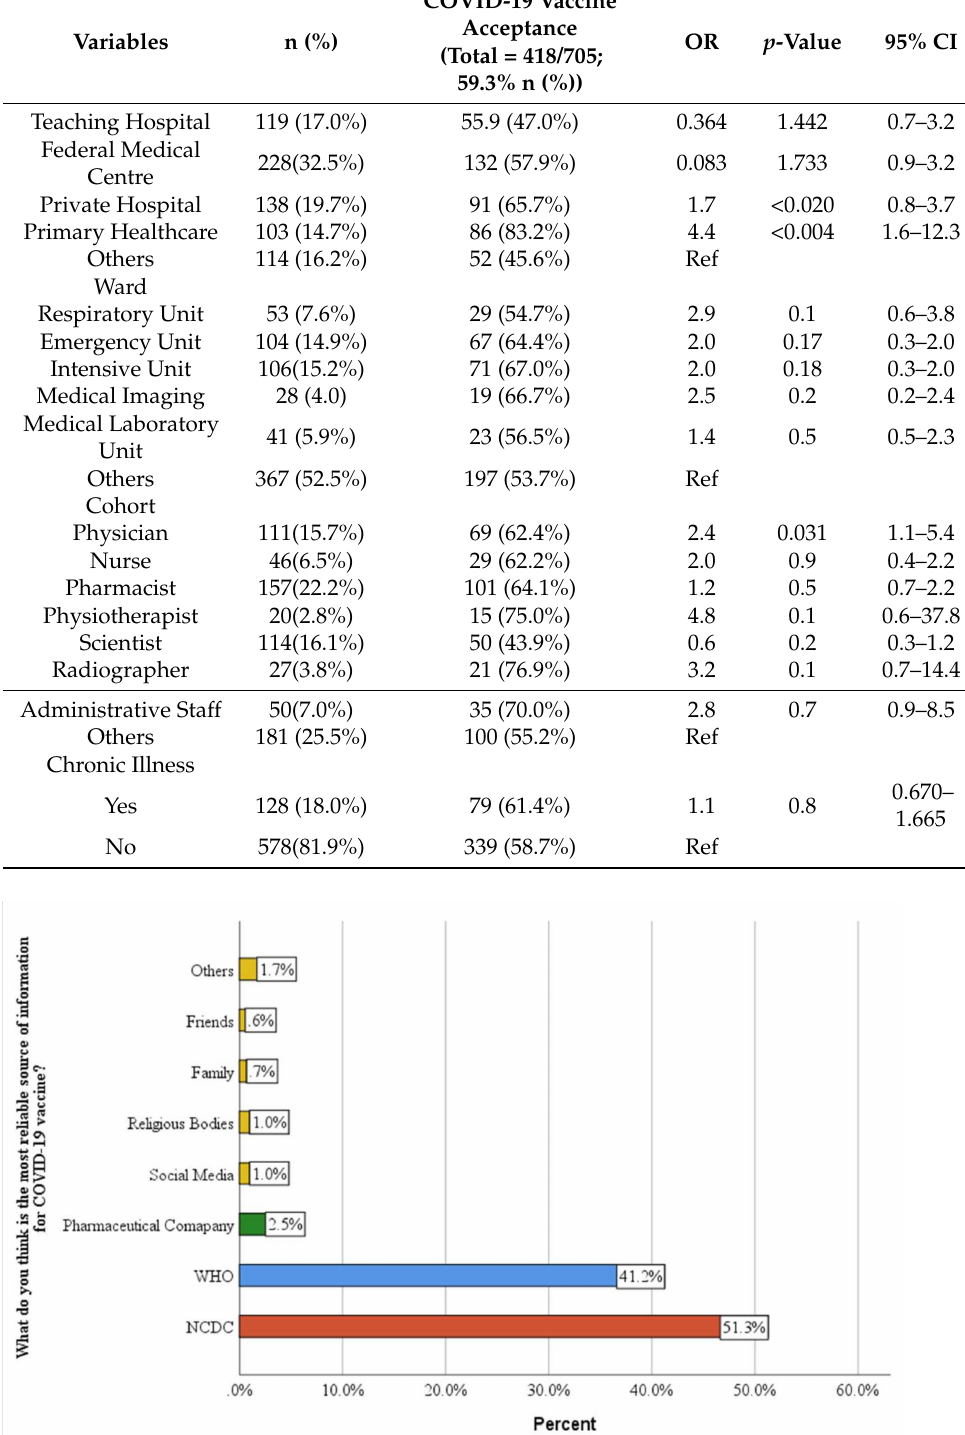
Figure 1. Reliability of COVID-19 sources of information across COVID-19 vaccine